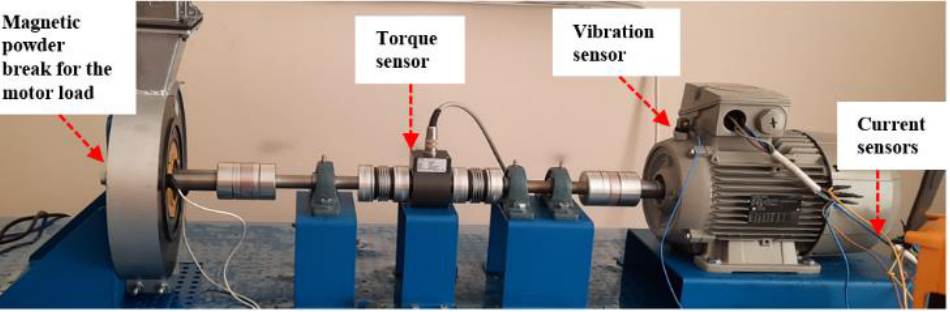
Figure 4. The testbed which is designed for generating artificially induced motor equipment faults.